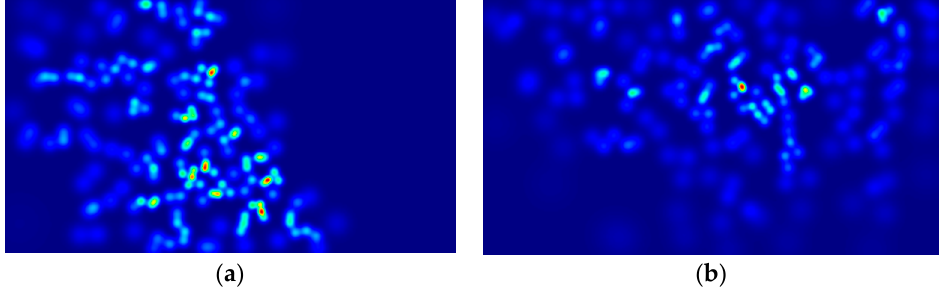
Figure 14. Comparison of the different distributions representing similar quantities: ( a ): 165 and ( b ): 162.